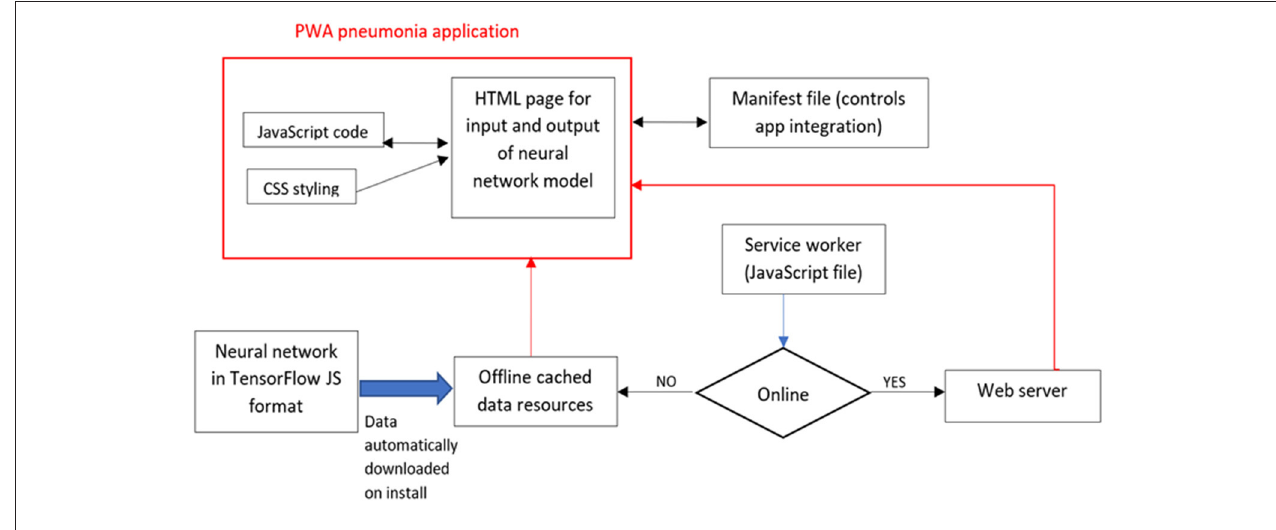
FIGURE 1 | Structure of PWA for pneumonia prediction.